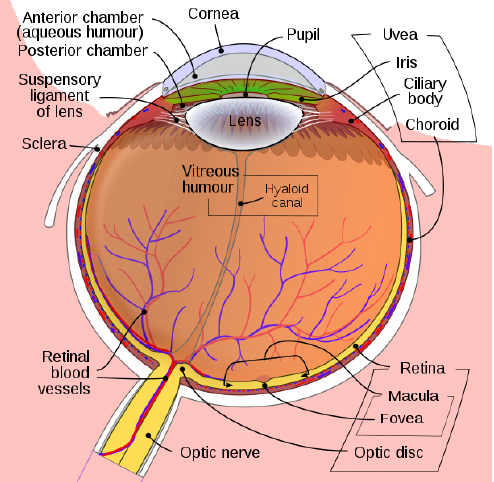
Figure 1. The Human Eye. Adapted from Wikipedia.